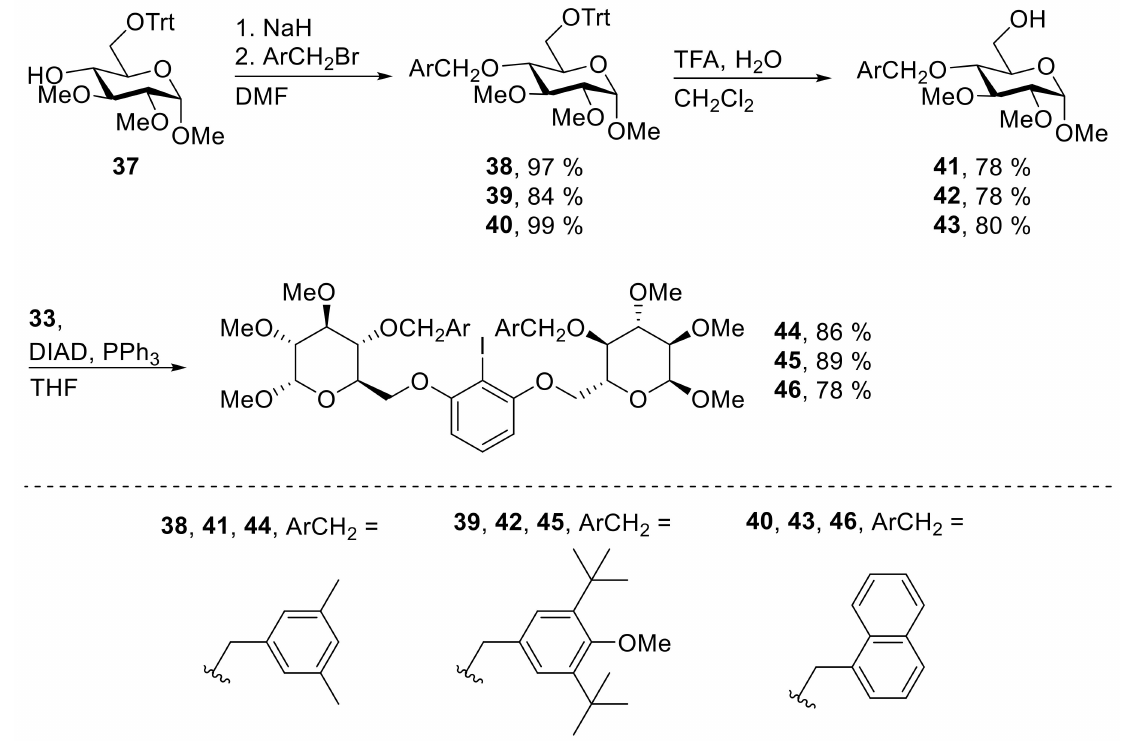
Scheme 6. Preparation of α - d -glucose-based iodoarenes 44 , 45 , and 46 with a bulky substituent at position 4 and small methyl groups at positions 1, 2, and